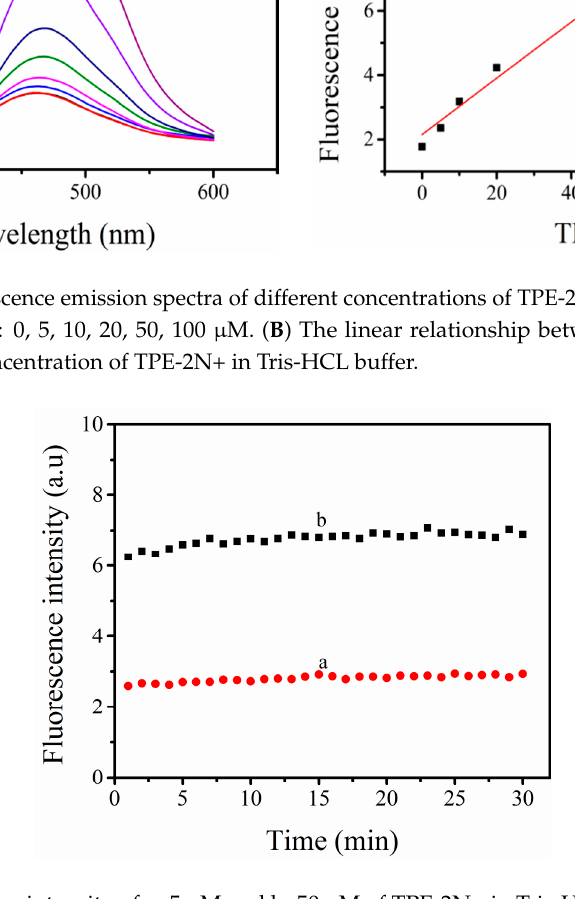
Figure 2. Fluorescence intensity of a: 5 μ M and b: 50 μ M of TPE-2N+ in Tris-HCL buffer over a time period of 30 min.